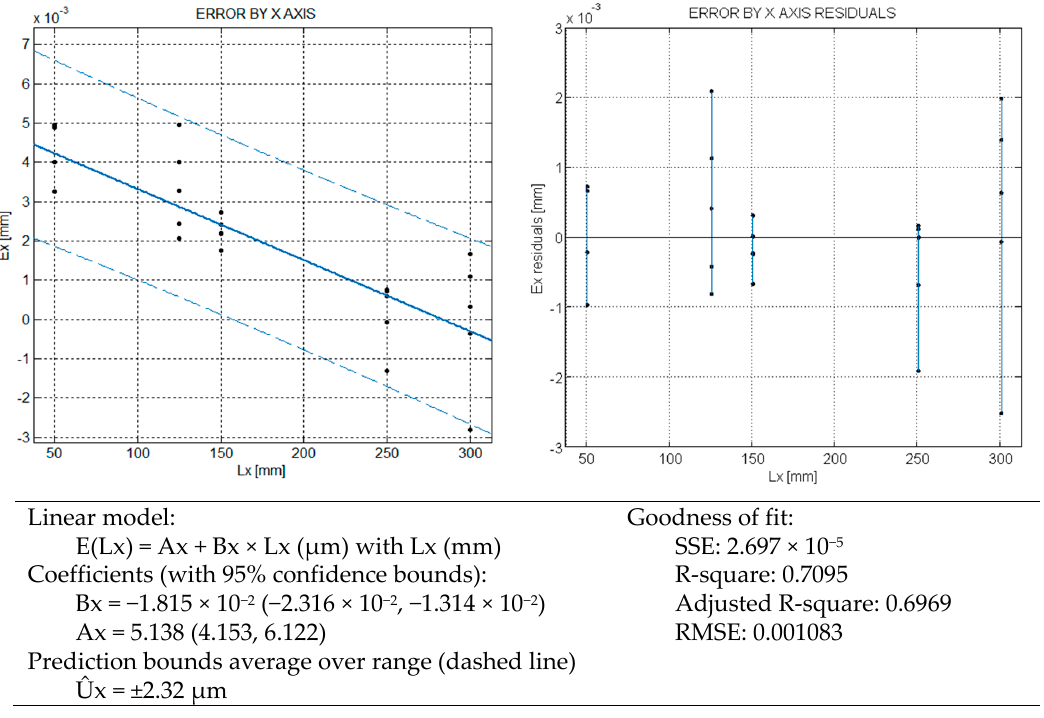
Figure 3. CMM error model by X axis.